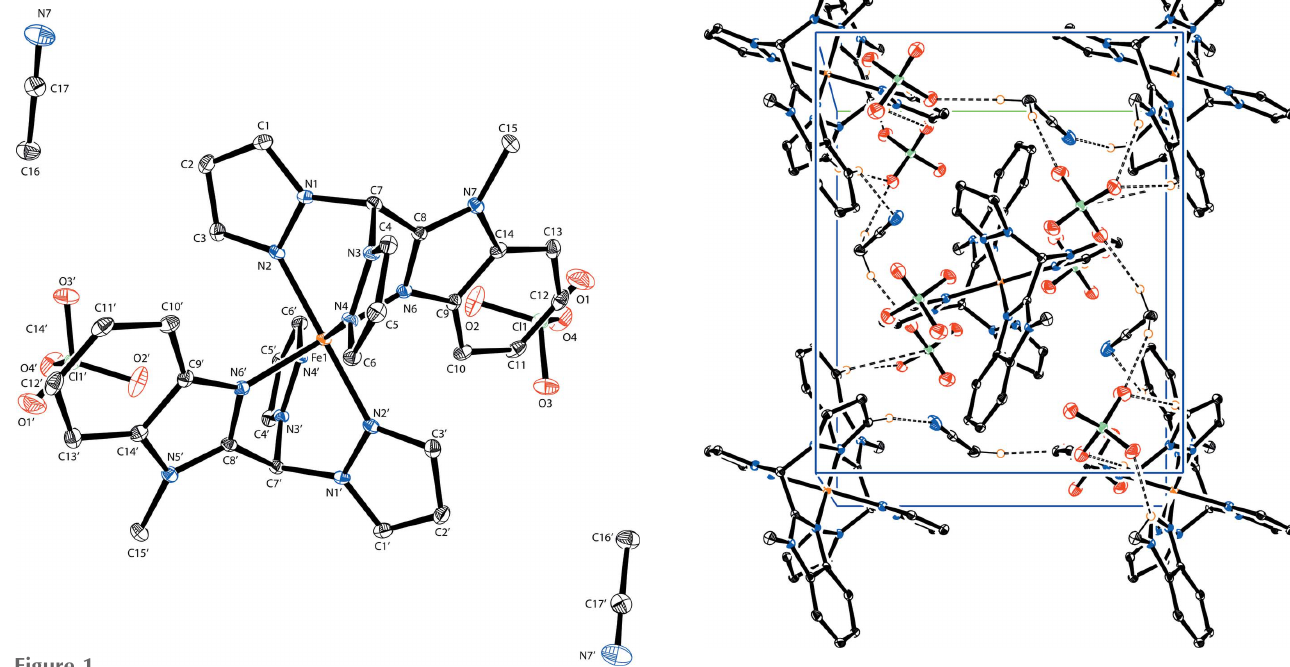
Figure 2 A view along the a axis, emphasizing the weak C—H (cid:2)(cid:2)(cid:2) O and C—H (cid:2)(cid:2)(cid:2) N interactions which promote the crystal packing in the unit cell of the title compound. Only H atoms involved in these interactions are shown.